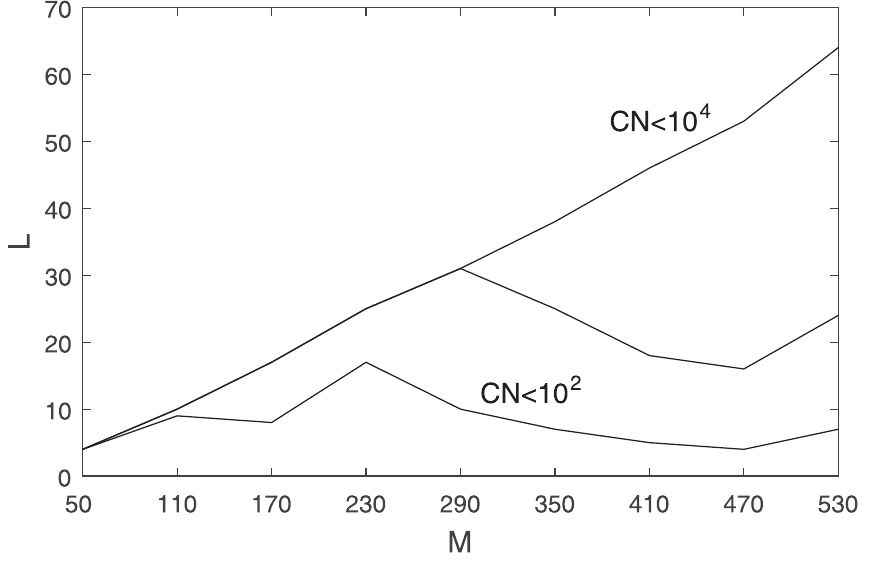
Fig 6. Best L corresponding to best MSE values subject to different limits on condition number, 10 2 associated with the line on the bottom, 10 3 associated with the line in the middle, and 10 4 associated with the line on top.